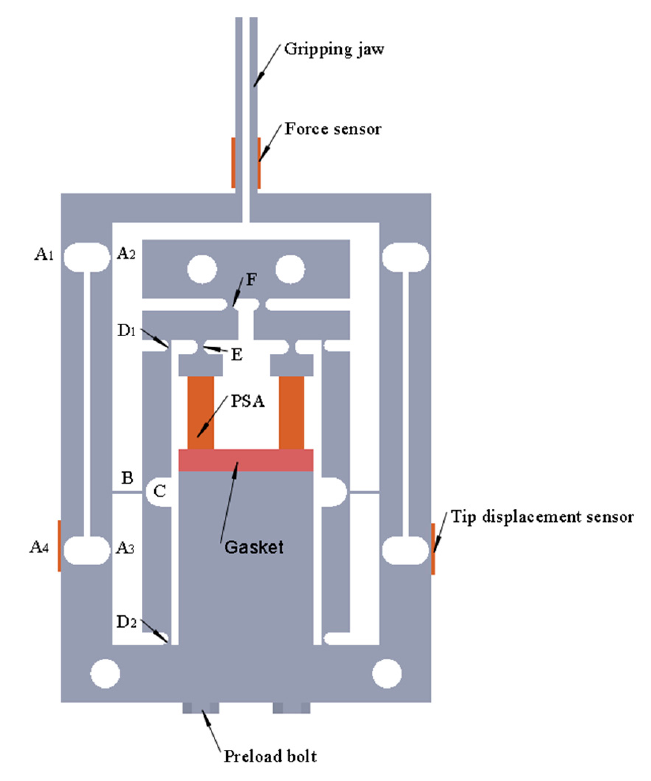
Figure 1. Mechanical structure of the microgripper.